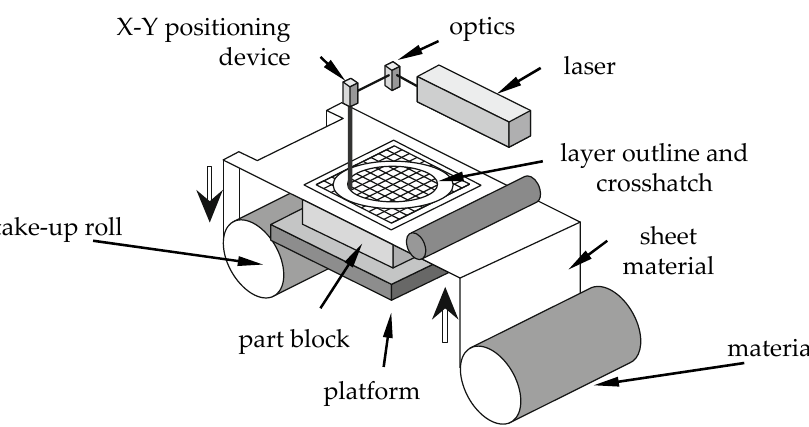
Figure 13. Schematic representation of laminated layer manufacturing (based on [50]).